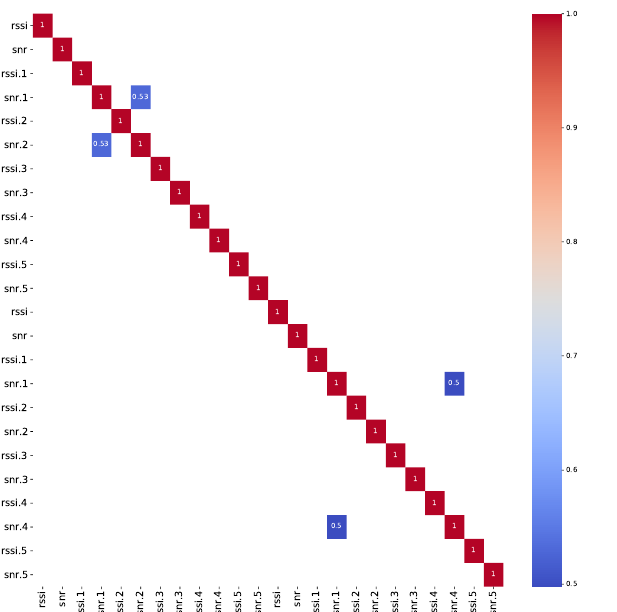
Figure 11. Data correlation for RSSI and SNR values for ROOM A509 and location points 9 and 10 for SF 9.